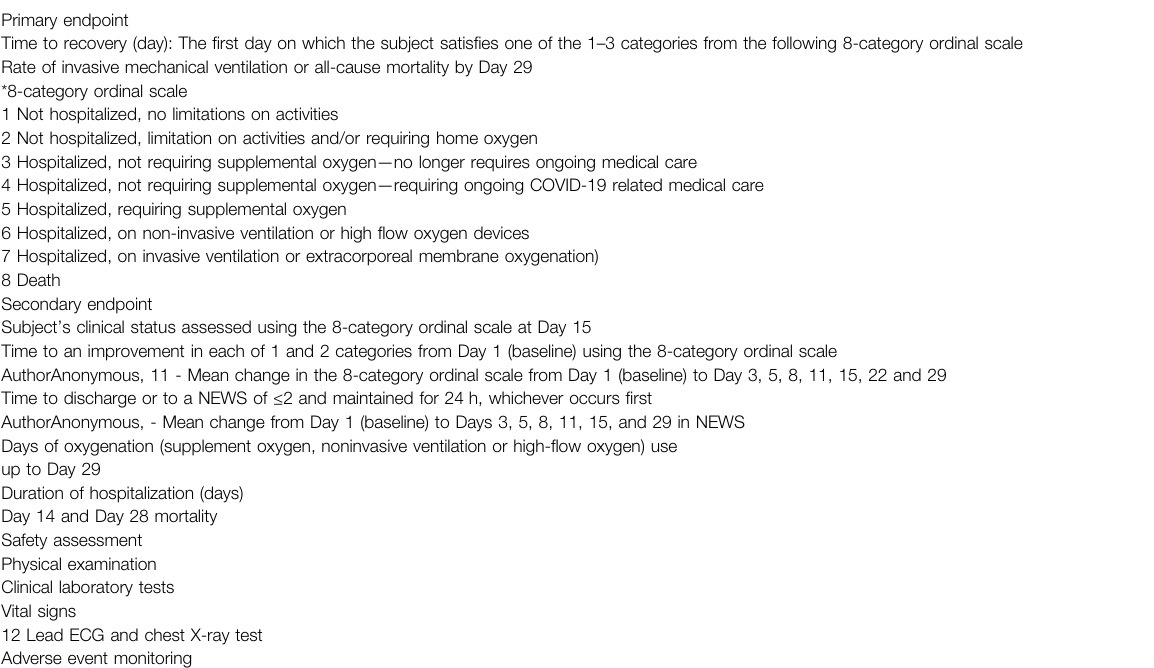
TABLE 5 | Suggested study endpoint of the study design of an anti-in fl ammatory agent for COVID-19. Primary endpoint Time to recovery (day): The fi rst day on which the subject satis fi es one of the 1 – 3 categories from the following 8-category ordinal scale Rate of invasive mechanical ventilation or all-cause mortality by Day 29 *8-category ordinal